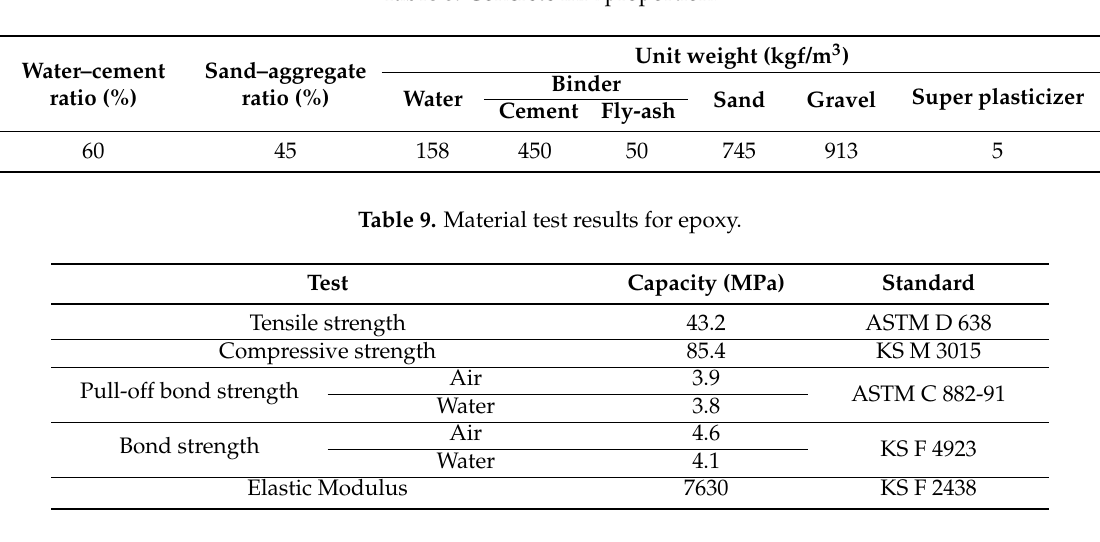
Table 8. Concrete mix proportion.